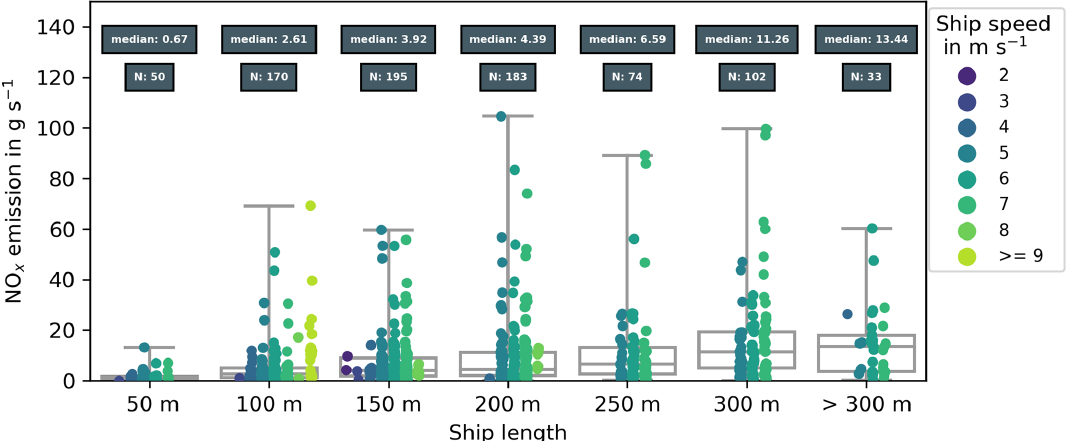
Figure 8. Box plot of NO x emission rates in grams per second for different ship lengths. Boxes indicate the 25th and 75th percentile, the line in the middle is the median, and the bars show minimum and maximum values. Dots show individual measurements and are colour coded by corresponding ship speed. Dark grey boxes show the median emission rate and total number of observations for this length class. Data of dredging ships have been